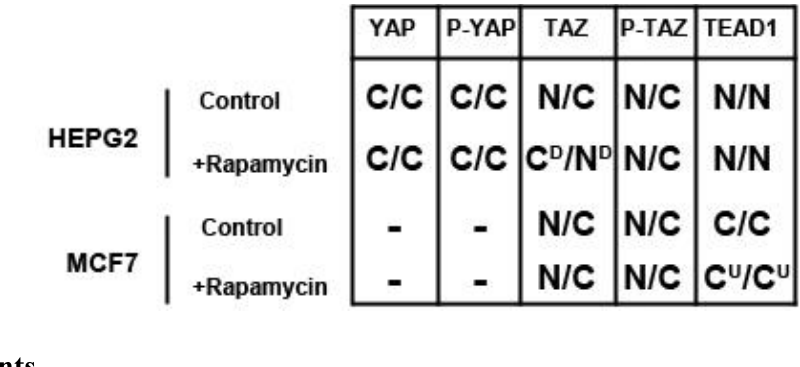
Figure 7. Effects of rapamycin treatment on Hippo pathway components in HepG2 and MCF7 cells. Cytoplasmic (C) or nuclear (N) localization and downregulation (D) or upregulation (U) of Hippo pathway components at low density (left) and high density (right)